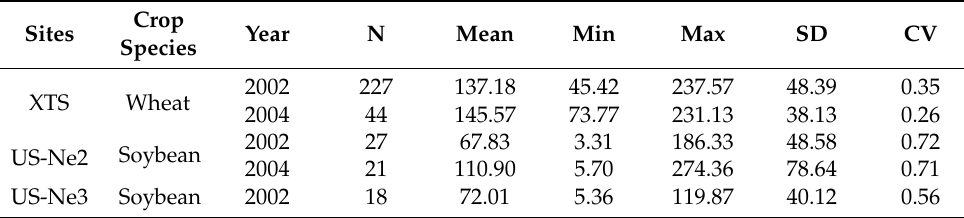
Table 2. Summary statistics for the measured wheat and soybean CCCs ( µ g cm − 2 ).